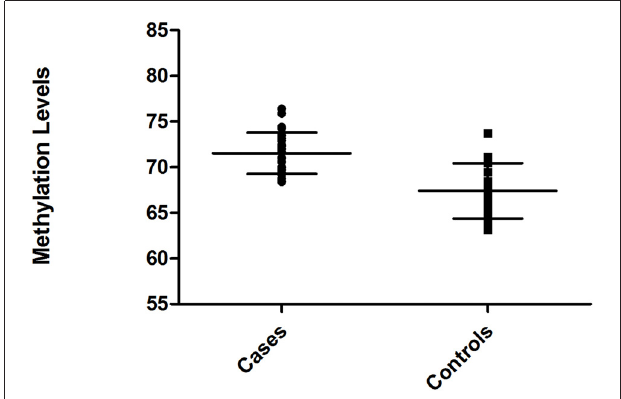
FIGURE 3 | Distribution of methylation levels of intragenic CDH23 CpG island for ARHI patients (cases) and healthy controls (Controls), generated using GraphPad Prism